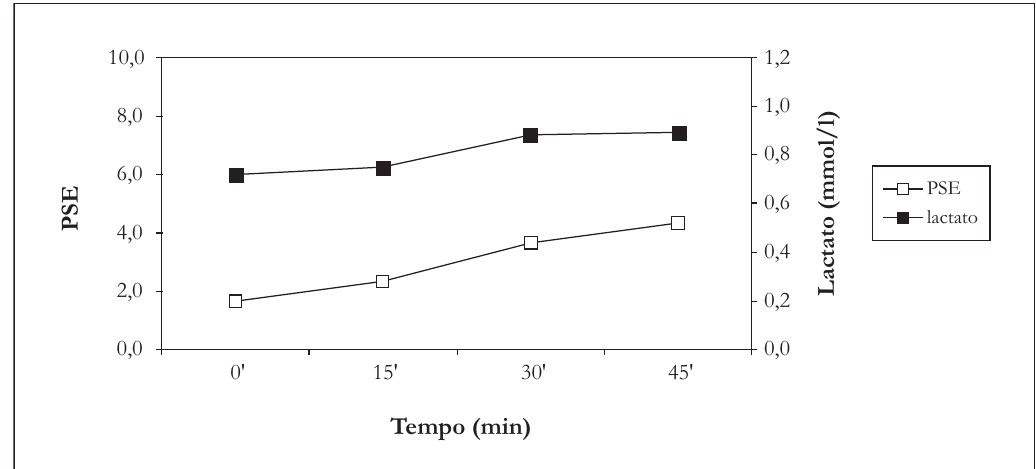
Figura 3 - Relação das médias de concentrações plasmáticas de lactato e PSE nos intervalos de 0 a 45 min. Os valores representam a média ± e.p.m. das 6 sessões de